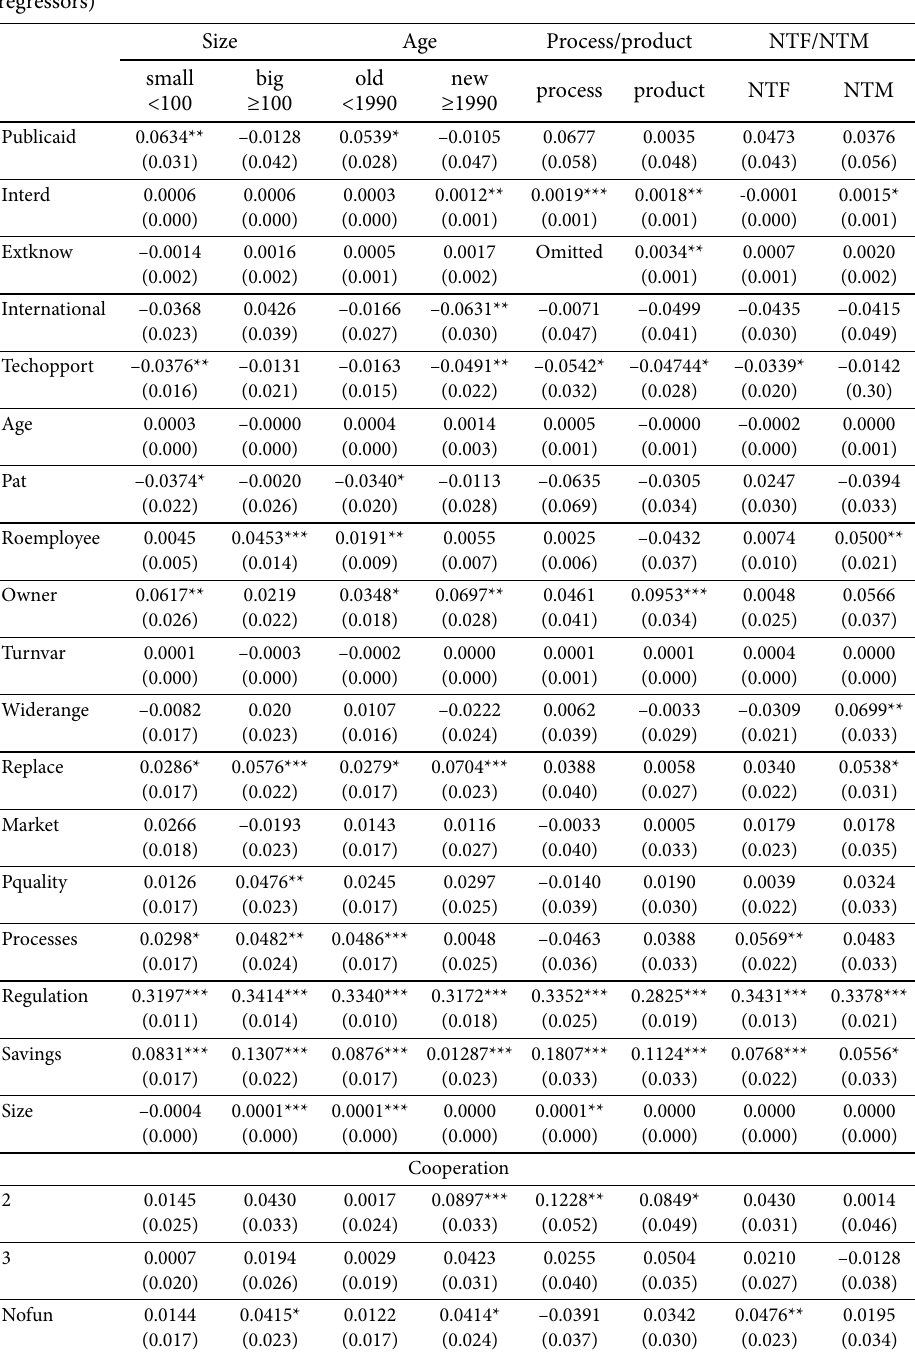
Table 4. Results of the estimations (average marginal effects of the probit model with endogenous